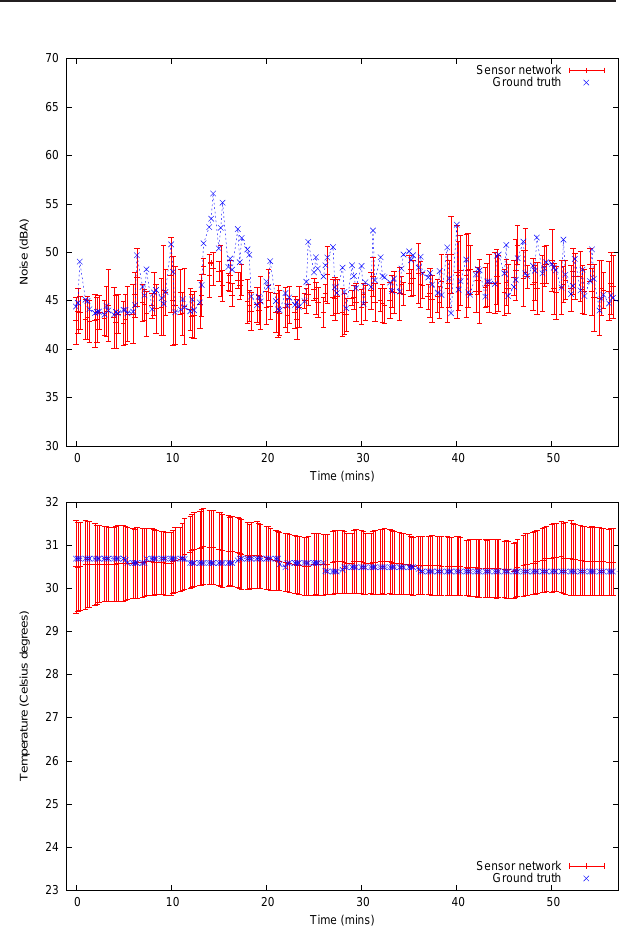
Figure 2. Average estimation of the sensor network for the parameters ”noise” (top) and “temperature” (bottom), with respect to external references during 1 hour with all the nodes